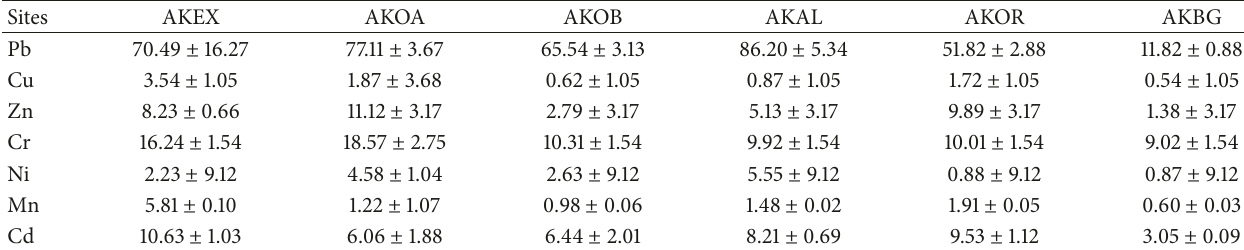
Table 3: Mean values of total metal content ( 𝜇 gg −1 ) ± standard deviation of dust